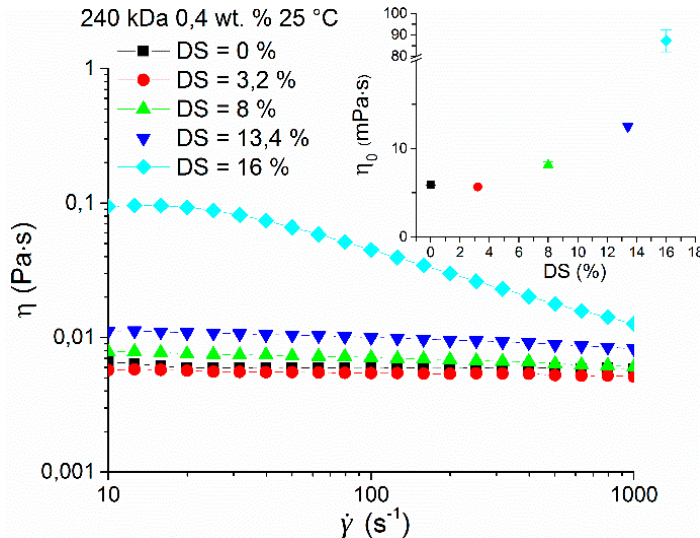
Figure 5. Dependence of viscosity on the shear rate of HA-UDA (240 kDa) with a concentration of 0.4 wt.% and various degree of substitution (DS) in physiological solution (0.9 wt.% of NaCl) at 25 °C. The inset shows the dependence of the determined zero shear viscosities on DS. The graph contains a break between 20 and 80 mPa·s for better clarity.